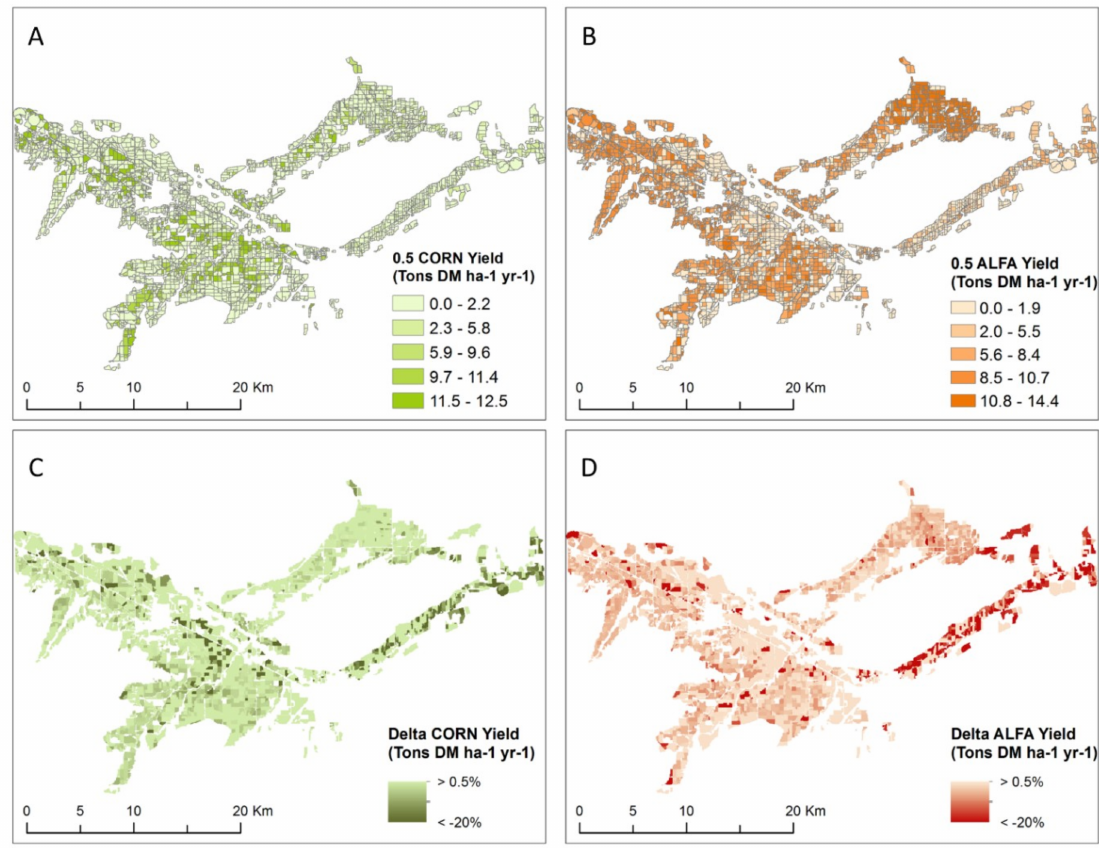
Figure 17. Spatial distribution of species-specific crop yield averaged over the 1999–2016 time period for ( A ) corn and ( B ) alfalfa under the 0.5 scenario. ( C , D ) shows the percentage decreases in crop yield after reducing the irrigation water for corn and alfalfa,